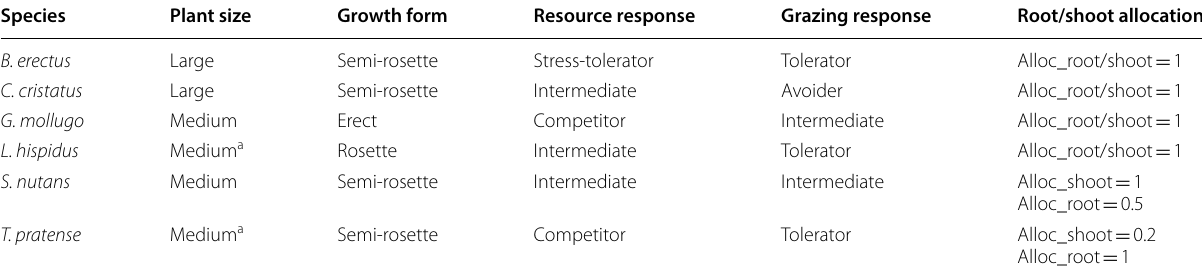
Table 3 Classification of species into plant functional types (PFT) according to the classification rules [21] and current